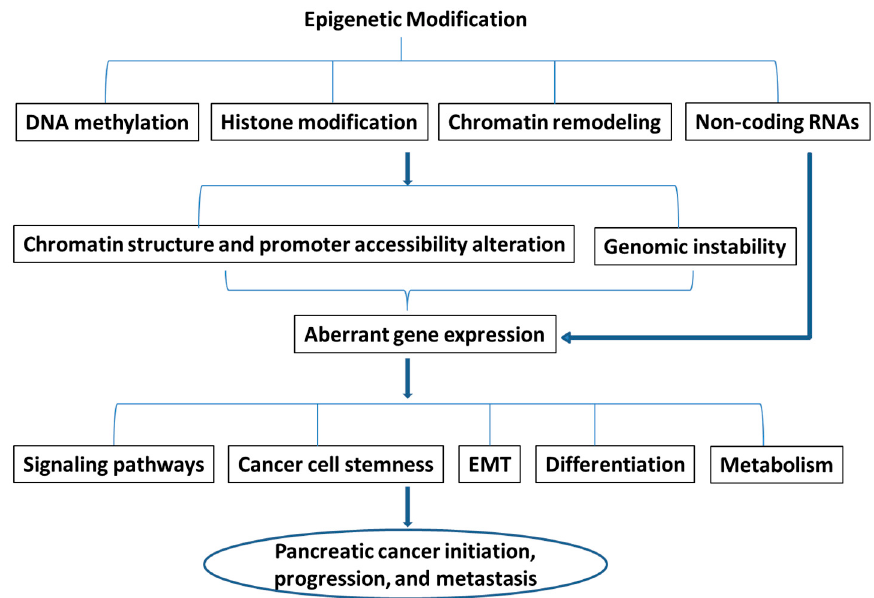
Figure 2. A diagram to summarize the role of epigenetic modifications in pancreatic cancer development and progression. Arrow indicates leading to or promoting. EMT: epithelial–mesenchymal transition.